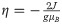
The exchange interaction.The exchange interaction is defiend in Eq (3), but η=-2JgμB is used instead of J for better comparison with the hyperfine interaction strength. For values of η comparable with the hyperfine coupling a1 = 500 μT the singlet-triplet mixing of the radical pair is supressed, leaving the radical pair largely in its initial singlet state.